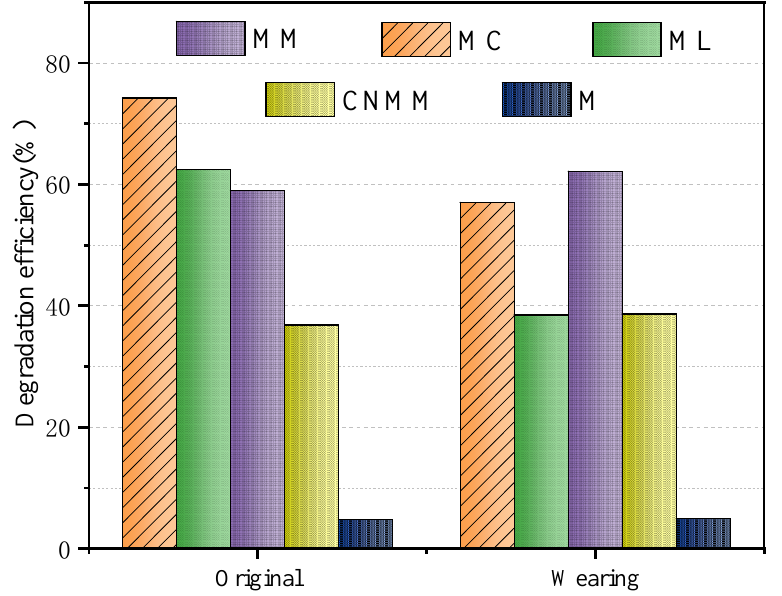
Figure 11. Photocatalytic NO x degradation efficiency of different cement mortars after wearing. The microstructure and morphology of the coated mortars before and after the wearing tests were investigated by SEM-EDS. As shown in Figure 12, thin layers of g-C 3 N 4 /CoAl- LDH-based coatings can be observed, and are loading uniformly on the raw surface of the mortars’ substrates. Obviously, the porous microstructures of both the MC (Figure 12a)